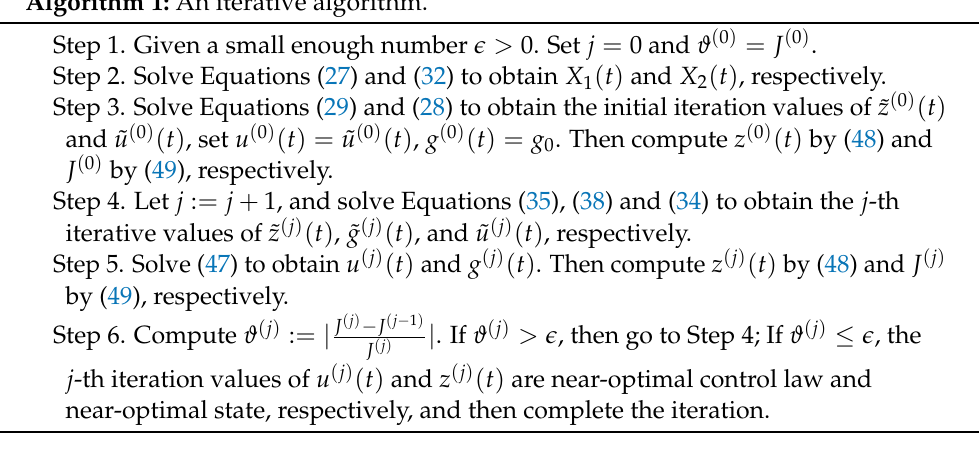
Algorithm 1: An iterative